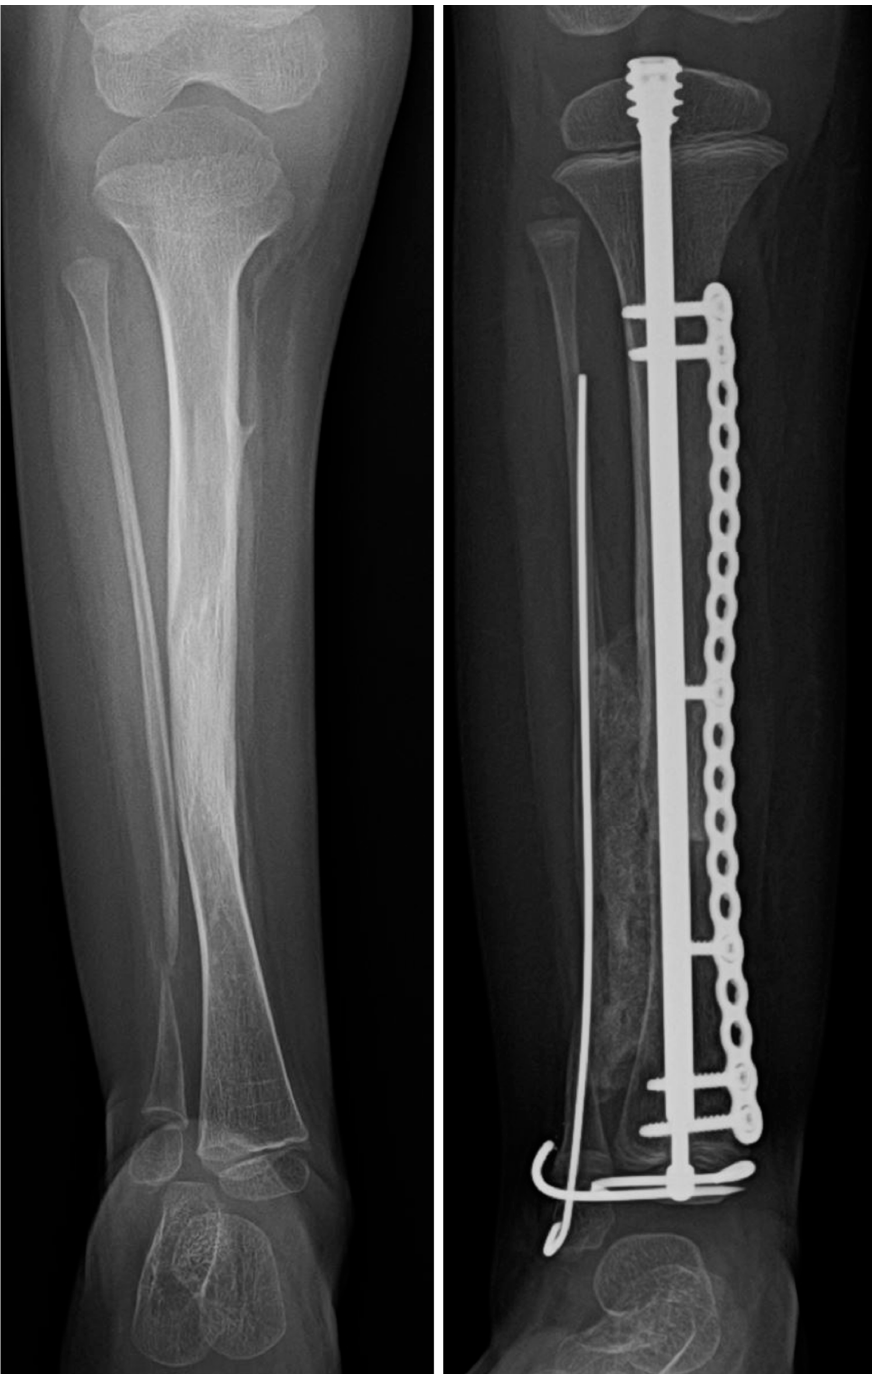
Figure 8. The image on the ( left ) demonstrates the proximal fibular migration that can occur as a secondary change in CPT (type 2B). The image on the ( right ) shows the restoration of the fibular station after the cross-union procedure with fibular distalization. The fibula is brought down and stabilized with a wire fixing it to the tibia in the corrected position.